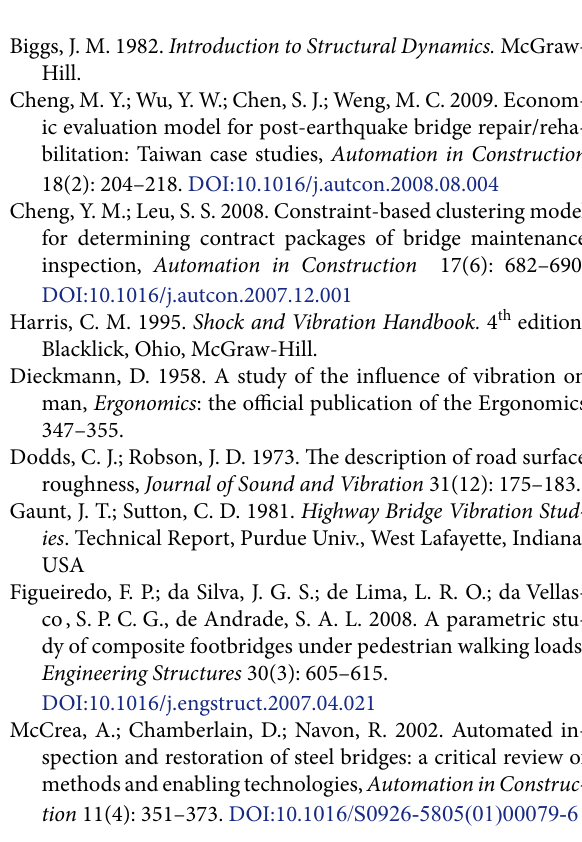
Fig. 15. Procedure for evaluating serviceability of